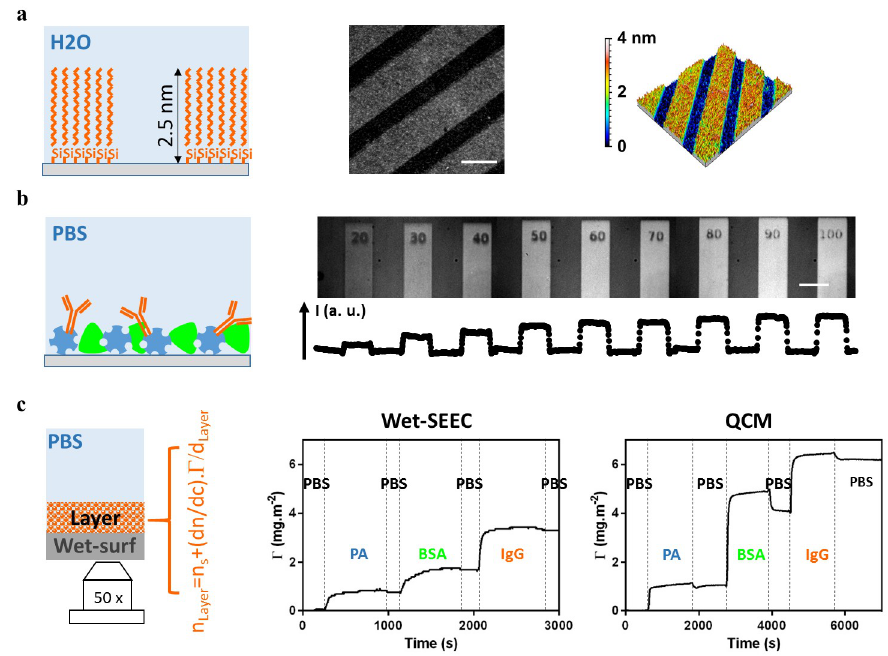
Fig 2. Nanoscopic measurement and imaging of dense and hydrated molecular layers. (a) Analysis of dense layers: Schematic of an OTS layer grafted on a wet-surf (left). Raw Wet-SEEC image of OTS microcontact-printed stripes at λ = 546 nm and INA = 0.7 and magnification x63 (center). 3D sample topography reconstruction from Wet-SEEC image, the OTS layer is measured at 2.1 ± 0.5 nm (right). Scale bar 50 μ m (b) Analysis of hydrated layers: Schematic of proteins adsorption layer composed of a first layer of protein A (PA) printed by the LIMA technique[9] and further adsorption of Bovine Serum Albumin (BSA) and IgG antibody (left). Wet-SEEC image at λ = 546 nm and INA = 0.7 and magnification x63 of protein layers obtained for different doses of printing activation (right-top). Wet-SEEC intensity profile reveals an increase of protein adsorbed amounts versus the printing activation dose (right-bottom). Scale bar 50 μ m (c) Adsorption kinetic measurement: Schematic of the optical model for a hydrated film as a homogeneous layer of thickness and refractive index d and n (left). Adsorption kinetics measurement, Layer Layer adsorbed amount Γ vs. time, for sequential injections of PA, BSA and IgG proteins and rinsing with phosphate- buffered saline (PBS), as measured by Wet-SEEC (center) and Quartz microbalance (Right) techniques.